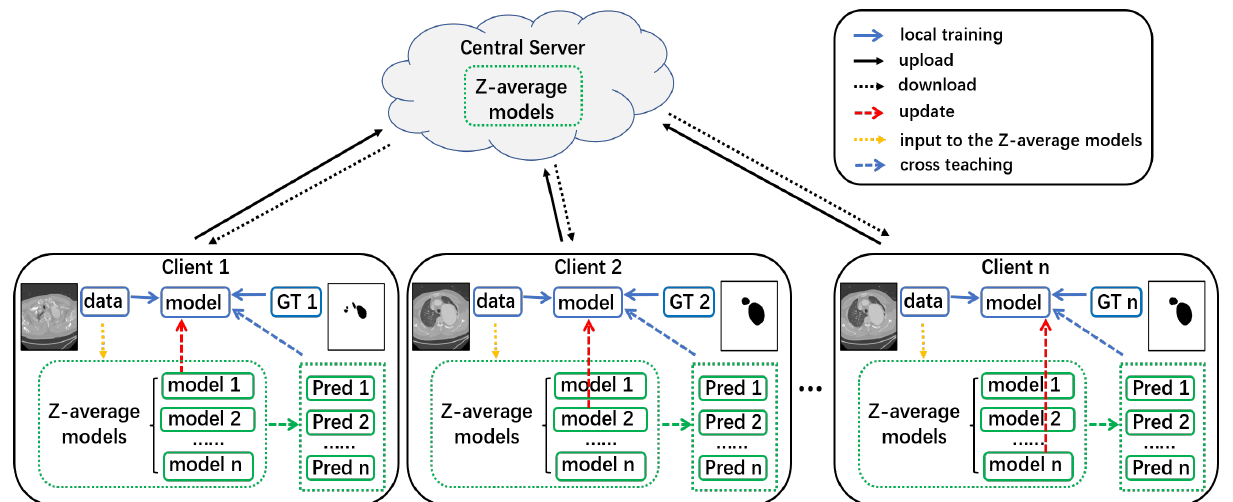
Figure 1. The framework of this study. After five local training processes, all clients upload the models to the global server. In total, n client models are aggregated to the Z-average models. Each client will download the Z-average models and update the corresponding local model. Then, in the next cross-training epoch, in total, n predictions from the Z-average models, as well as the local ground truth are used together to teach the local